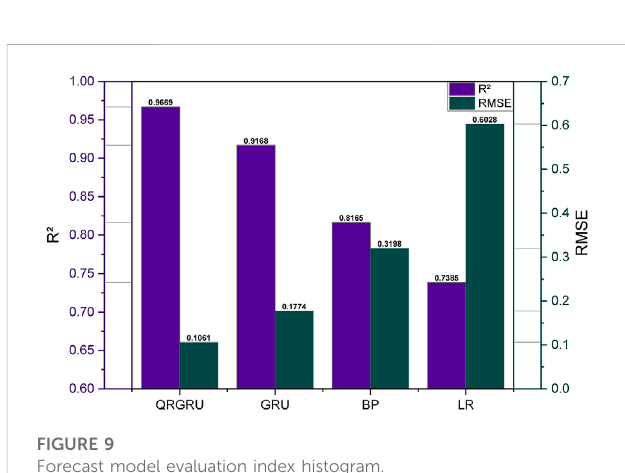
FIGURE 9 Forecast model evaluation index